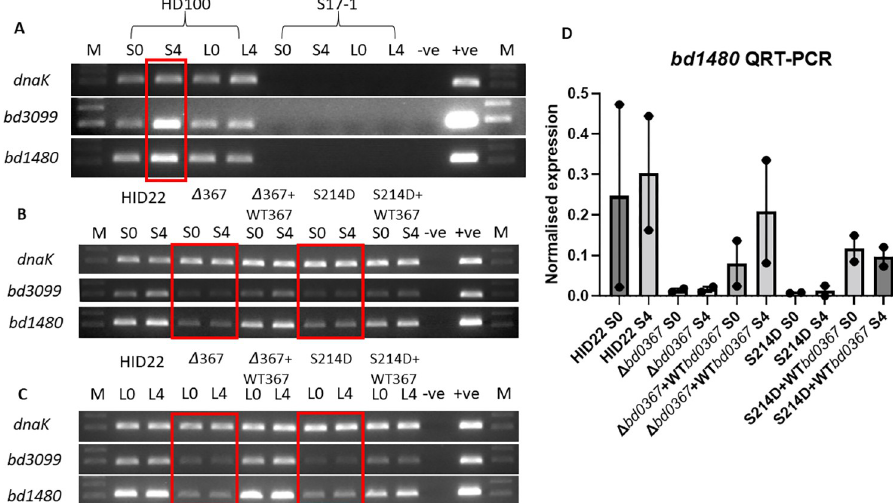
Fig 7. RT-PCR investigating gliding gene expression on a surface or in liquid. A- Expression of gliding genes bd3099 and bd1480 and control housekeeping gene dnaK in wild-type, HD grown, predatory B . bacteriovorus HD100 incubated on a surface for 0 (S0) or 4 hours (S4) and controls incubated in liquid (L0 and L4) show induction of the gliding genes, but not control gene dnaK at 4 hours on surface (red box). Control RNA isolated from the prey E . coli cells (S17-1) did not give products with these primers designed to specifically anneal to the Bdellovibrio genes. B- RT-PCR with RNA isolated from host independent (HI) strains incubated on a surface for 0 (S0) or 4 hours (S4) shows lower expression of predicted gliding genes in mutant strains ( Δ 367 and S214D) relative to wild type (HID22) and reconstructed wild-type bd0367 strains (+WT367; red boxes), but similar expression of control dnaK gene in all strains. C- HI cultured strains incubated in liquid for 0 (L0) or 4 hours (L4) also show lower expression of predicted gliding genes in mutant strains ( Δ 367 and S214D) relative to wild type (HID22) and reconstructed wild-type bd0367 strains (+WT367; red boxes), but similar expression of control dnaK gene. Images are representative of two independent repeats.–ve no template negative control, +ve genomic DNA positive control, M- NEB 100bp ladder; lower band 100bp, higher band 200bp. D- Quantitative RT-PCR to confirm expression pattern of bd1480 . Quantification of cDNA was by comparison to purified PCR product standard curve and normalized relative to whole signal from each biological repeat.